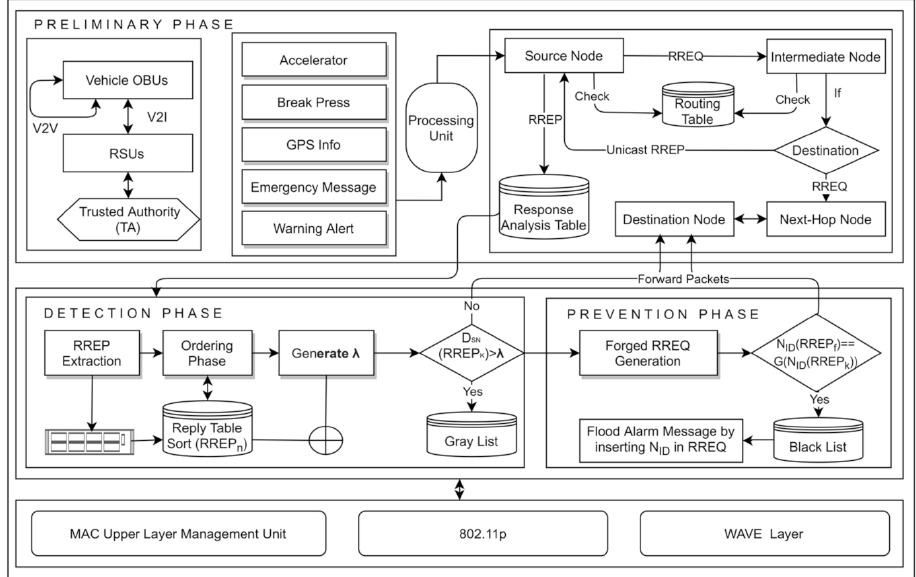
Figure 4. The framework of